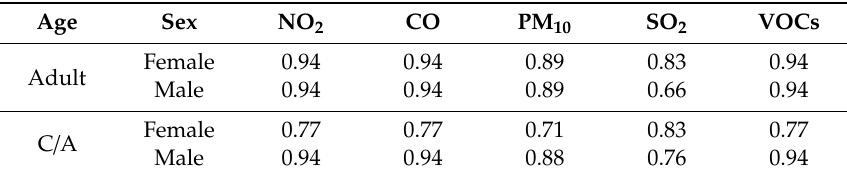
Table 3. Spearman correlation coefficients between the odds of PH and pollutants concentrations in adults, and children and adolescents (C/A)